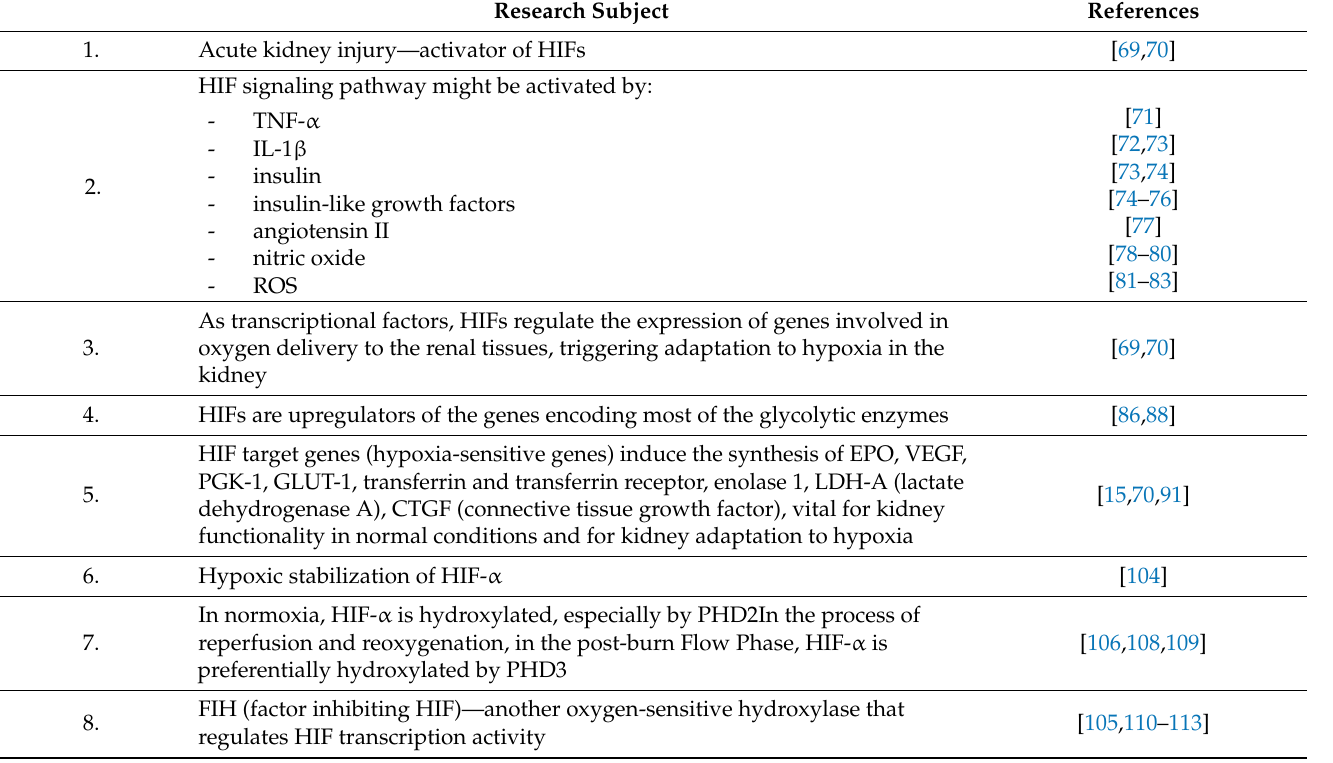
Table 1. The complex roles played by HIFs in renal hypoxia in the context of burns. Research